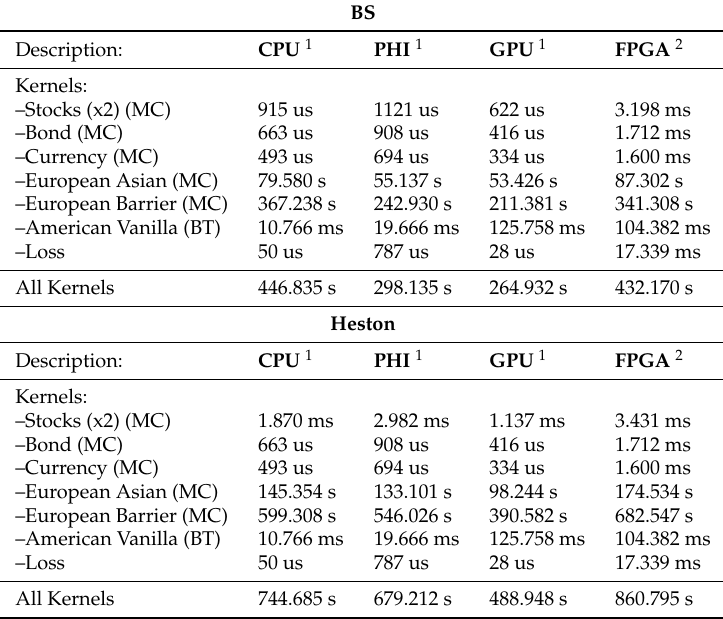
Runtime breakdown (s) with internal random number (RN) sequences — ( pathsMCext/pathsMCint ) = (32 k /32 k